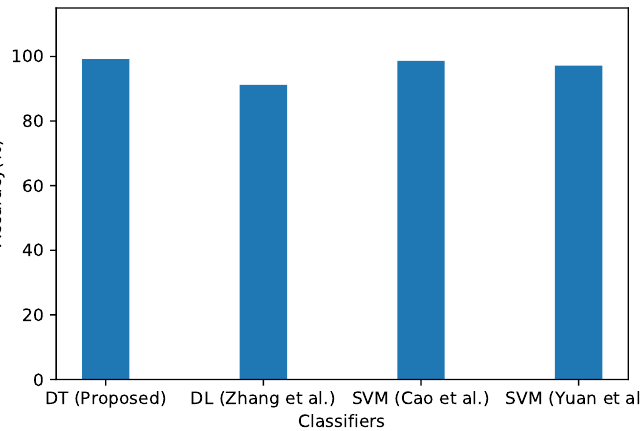
DT (Proposed) DL (Zhang et al.) SVM (Cao et al.) SVM (Yuan et al.) Figure 7. Accuracy comparison between the proposed DT algorithm, the DL method (Zhang et al.) in [35], SVM algorithm (Cao et al.) in [36], and SVM algorithm (Yuan et al.) in